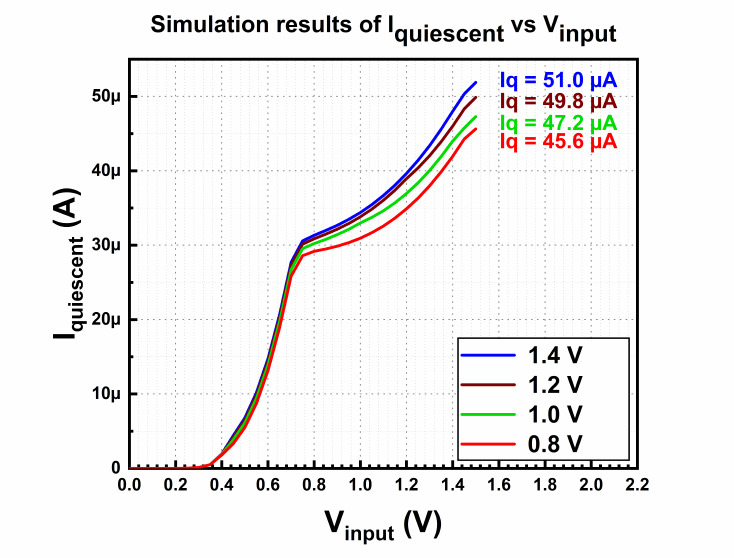
Figure 6. Simulation results of the MVD-LDO’s quiescent current.